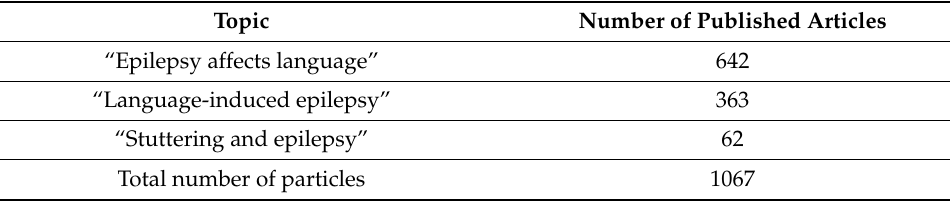
Table 1. Literature Review Strategy: Number of published articles per